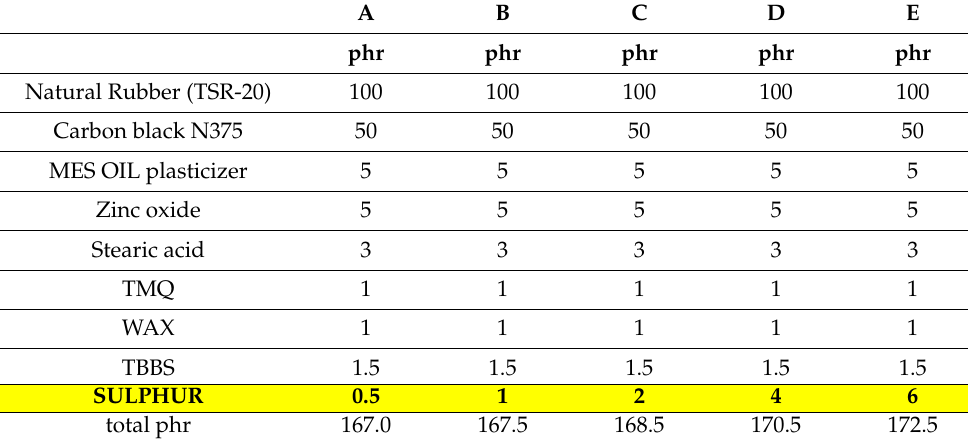
Table 1. NR-based compound formulation with variable levels of